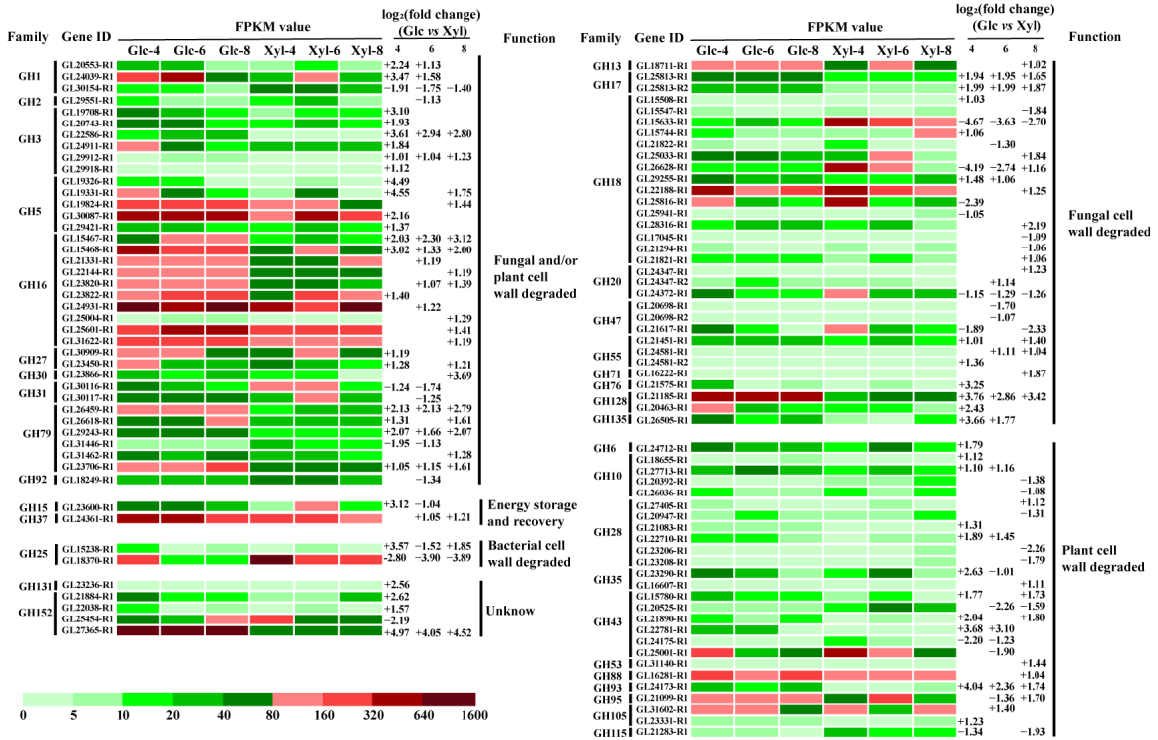
Figure 4. FPKM value and function of the differentially expressed genes in the glycoside hydro- lase family of Ganoderma lucidum on days 4, 6, and 8. Glc: glucose; Xyl: xylose. +: upregulated; − :